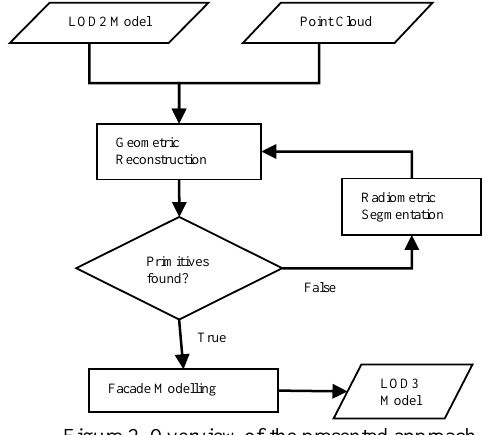
Figure 2. Overview of the presented